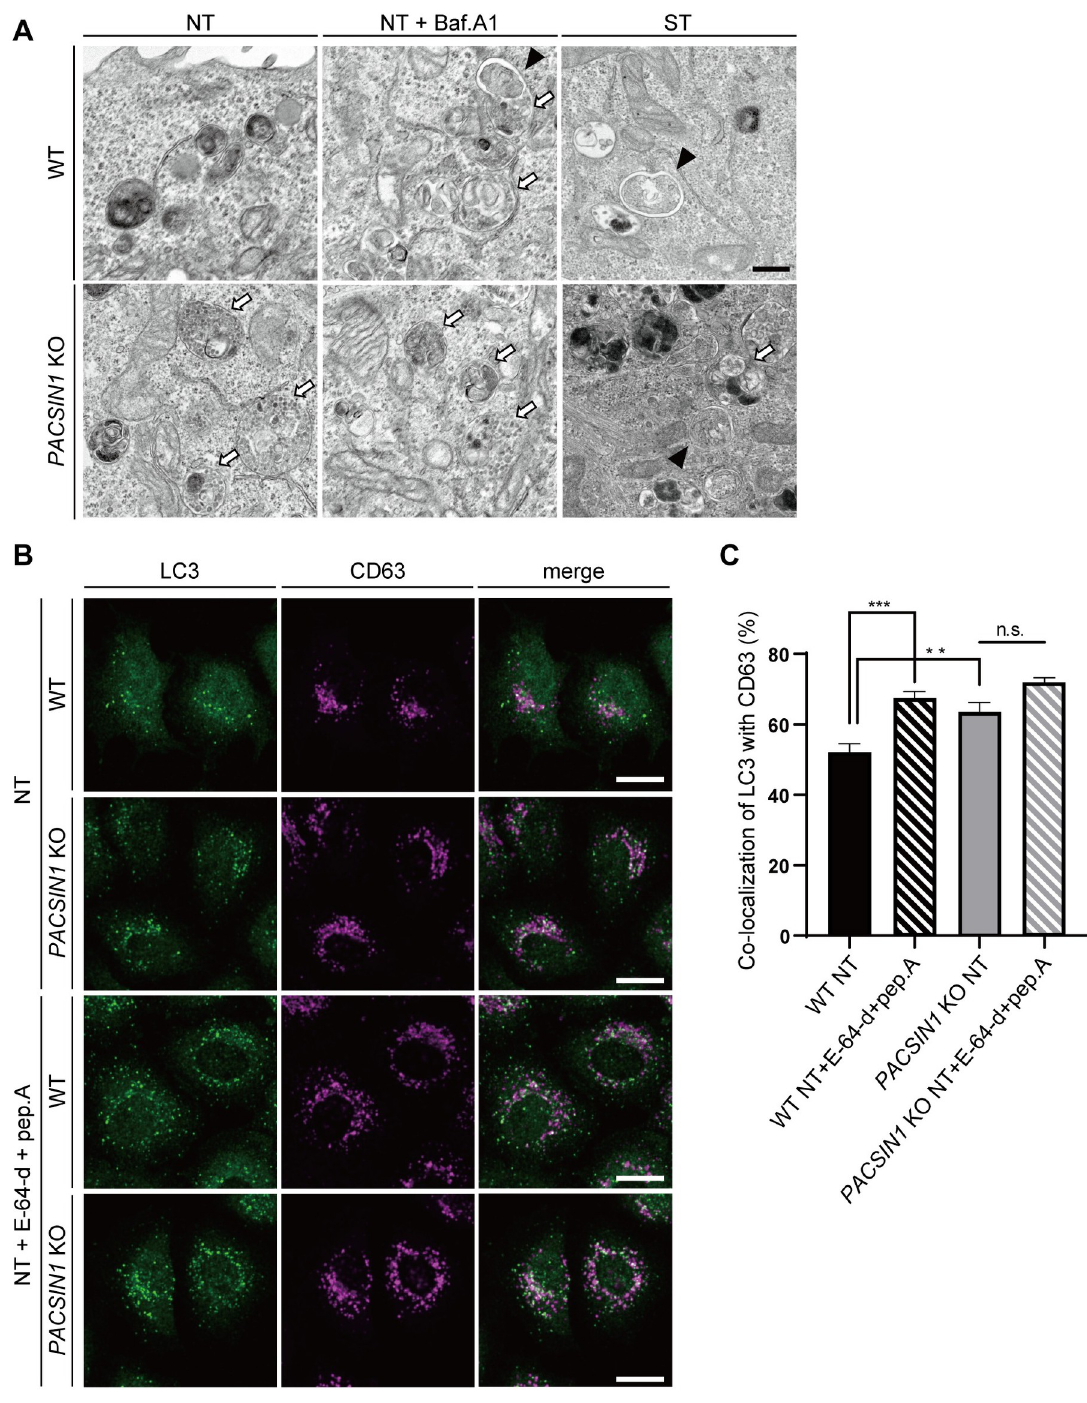
Fig 3. PACSIN1 depletion causes amphisome accumulation. (A) WT or PACSIN1 KO HeLa cells were cultured for 2 h in growth medium or EBSS, or for 6 h with 125 nM Baf.A1 in growth medium. After fixation, cells were analyzed by electron microscopy. Autophagosomes are indicated by arrowheads, and amphisomes are indicated by arrows. Scale bars, 500 nm. (B) WT or PACSIN1 KO HeLa cells were cultured for 2 h in growth medium with or without 10 μ g/mL E-64-d and pepstatin A. After fixation, cells were co- immunostained with anti-LC3 and anti-CD63 antibodies. Scale bars, 20 μ m. (C) The co-localization rate of LC3 with CD63 was quantified using CQ1 software, mean ± s.e.m. More than 200 cells were analyzed per condition in each experiment (n = 5). n.s.; not significant, �� p < 0.01, ��� p < 0.001 (one-way ANOVA with Tukey’s multiple comparisons test).